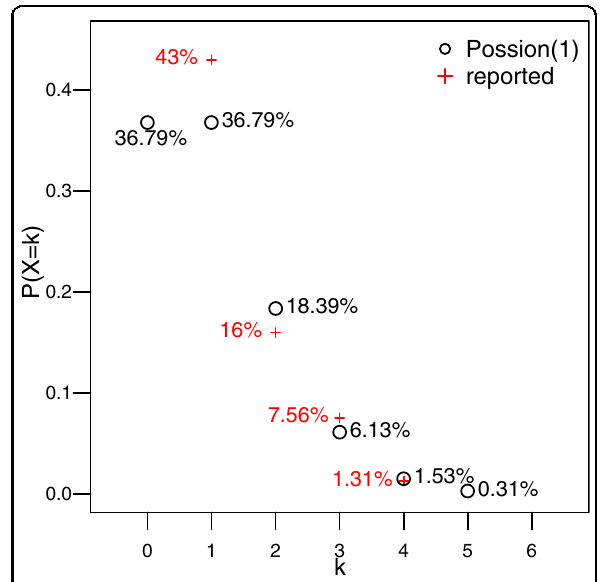
Fig. 1 Reported percentages of level 1 ( PSNE1 , 43%), level 2 ( APP , 16%), level 3 ( PSNE2 , APOE4 , on average 7.56 %), and level 4 (the average of TERM2 , SORL1 , ABCA7 , 1.31%) vs probabilities of Poisson distribution with the mean of 1. Here the frequency of Poisson distribution corresponds to the level of the EOAD gene